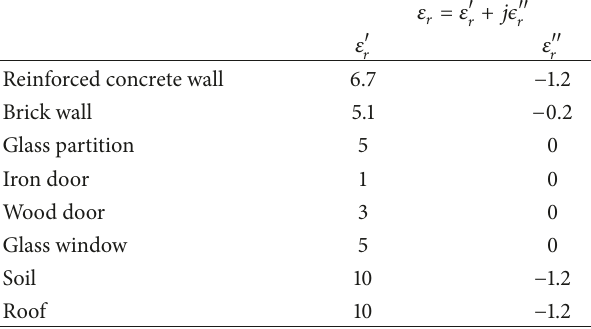
Table 1: The dielectric constants of